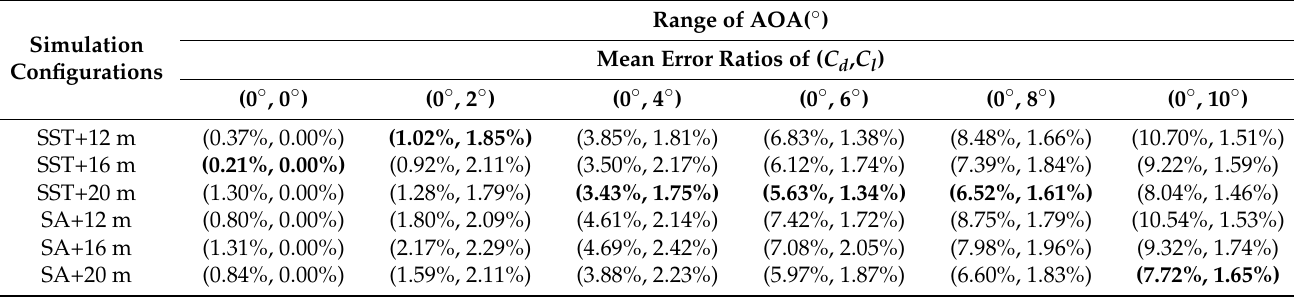
Table 8. The mean error ratios of C d and C l of the blunt trailing